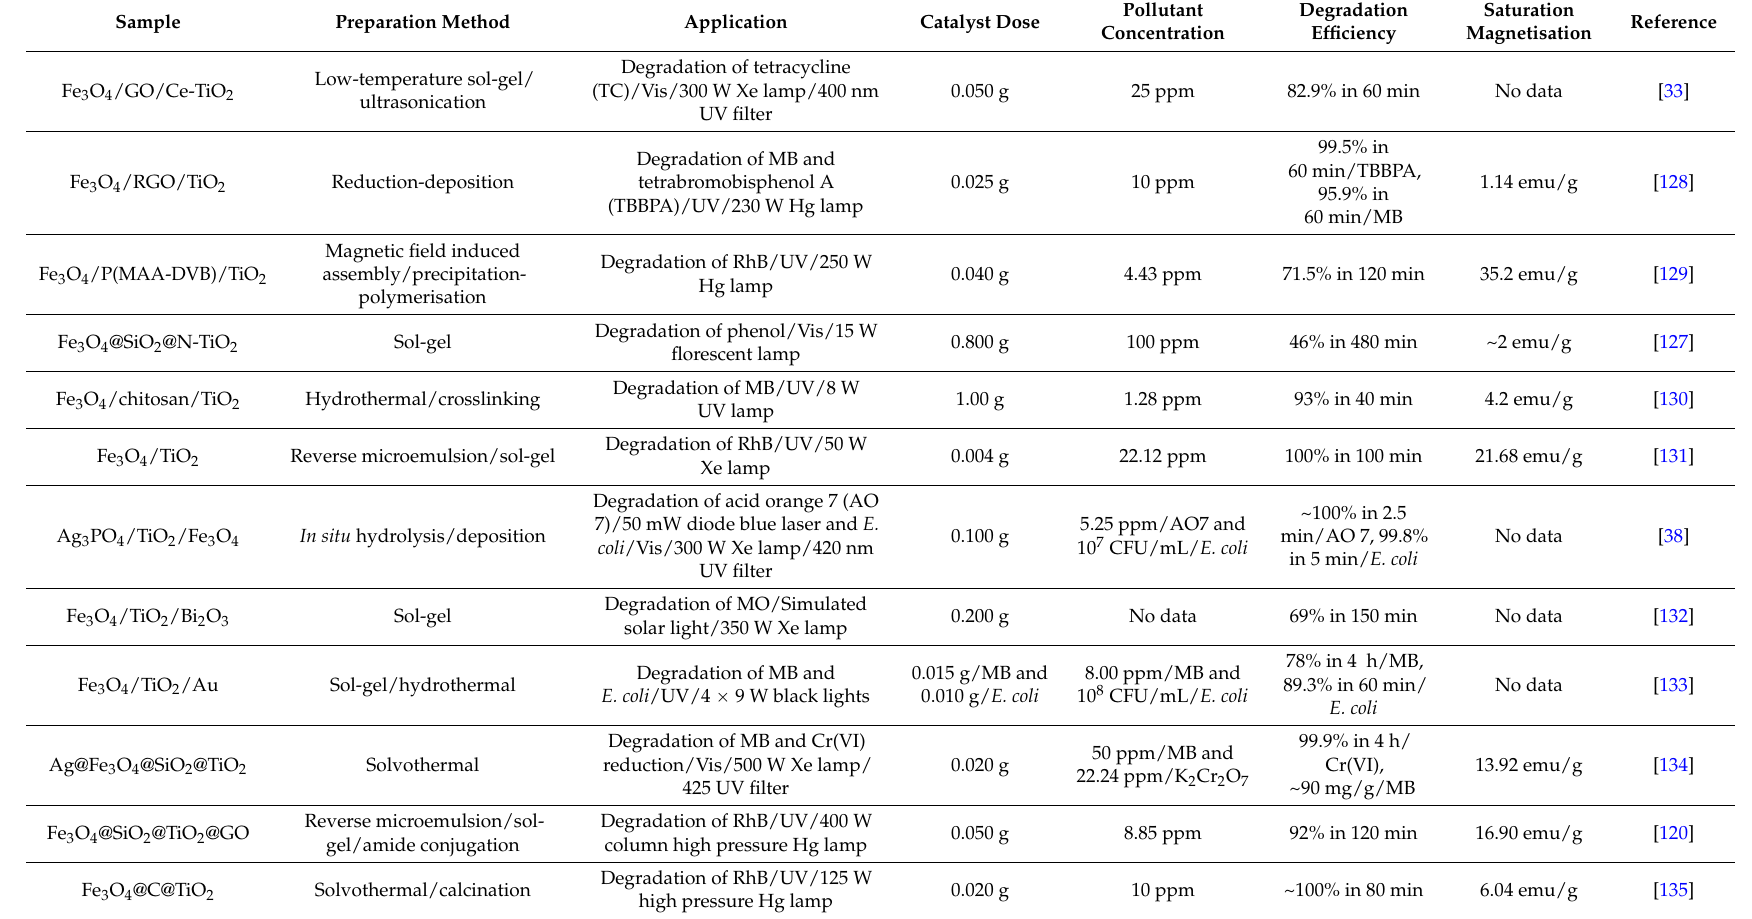
Table 1. Summary of the photocatalytic properties of Fe 3 O 4 -incorporating TiO 2 -based